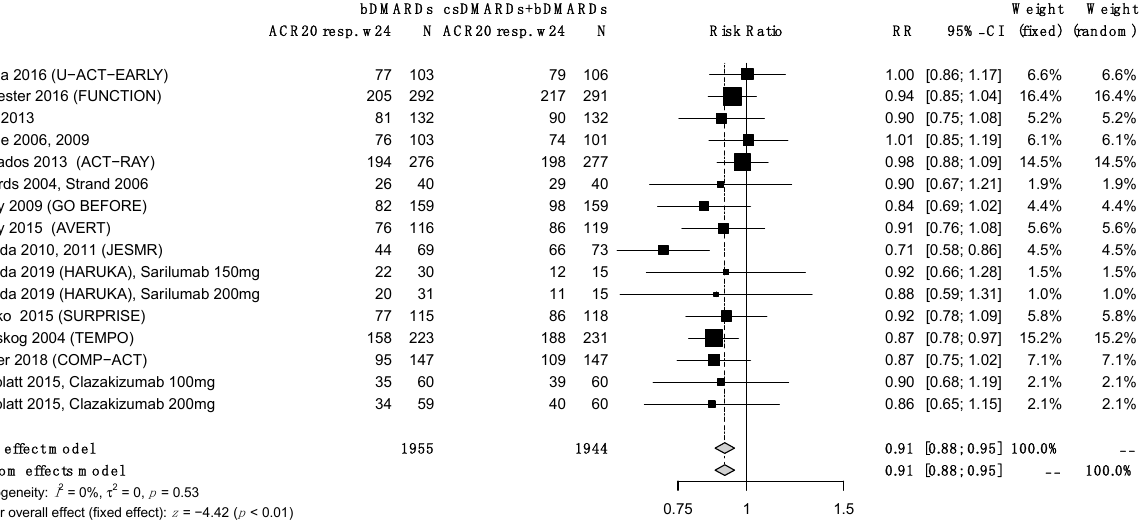
Figure 3. ACR 20 responses at week 24.